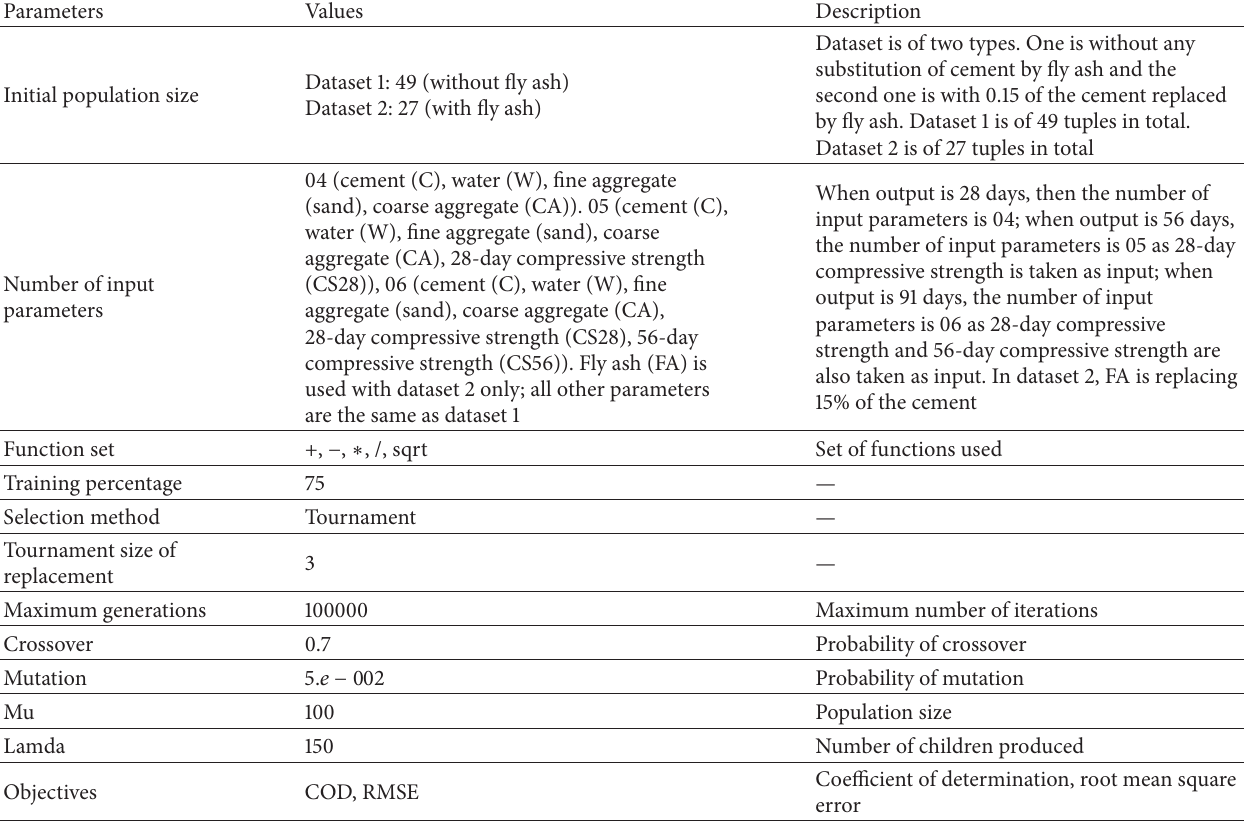
Table 6: Architecture selected for model 2 (GP model).